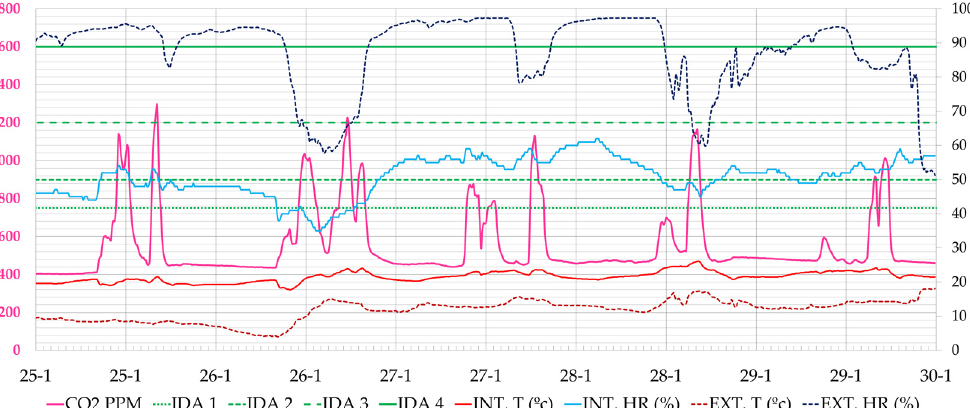
Figure 16. Evolution of CO 2 concentration, interior and exterior temperature and relative humidity in classroom A 1.1 during the week of 2021-01-25 to 2021-01-31 (Phase II). Source: authors. Classroom 2.1 shows similar records (Figure 17), with the peaks also varying from morning to afternoon depending on the occupancy of the classroom.